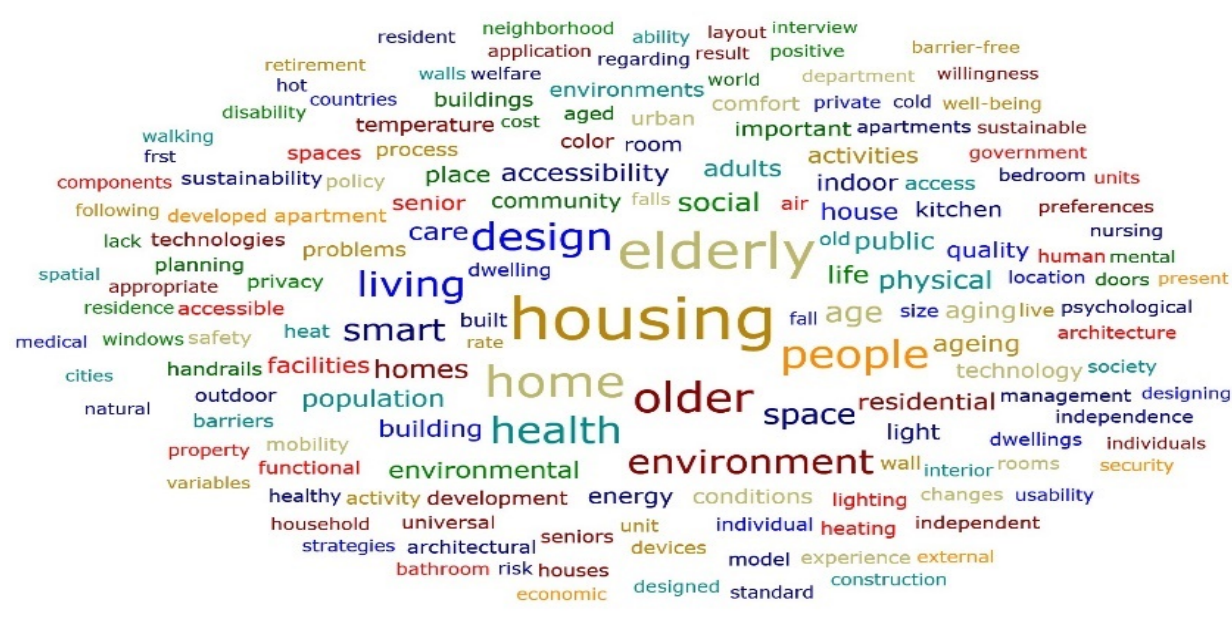
Figure 3. Word cloud of word frequencies from 51 documents.